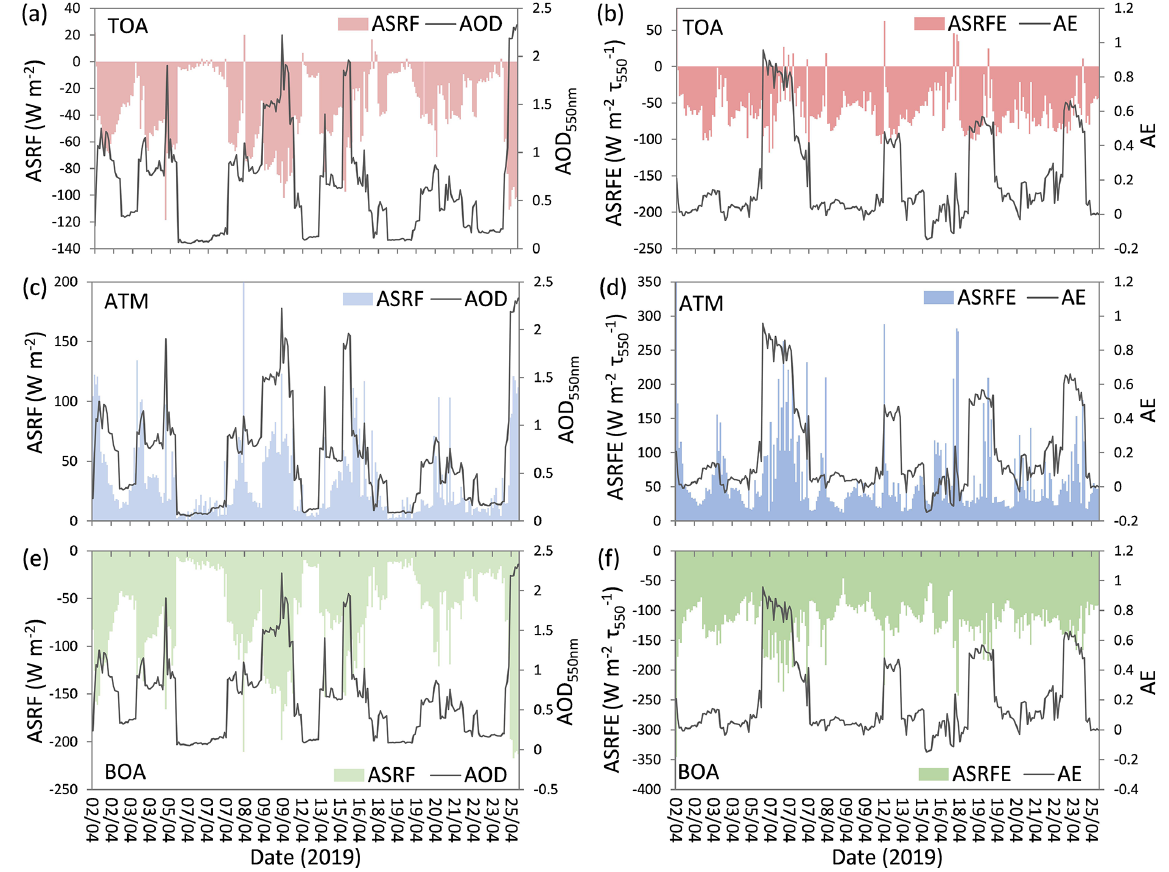
Figure 5. Instantaneous aerosol solar radiative forcing (a, c, e) and efficiencies (b, d, f) at the Kashi site during the DAO-K campaign ( a, b : TOA; c, d : ATM; e, f :